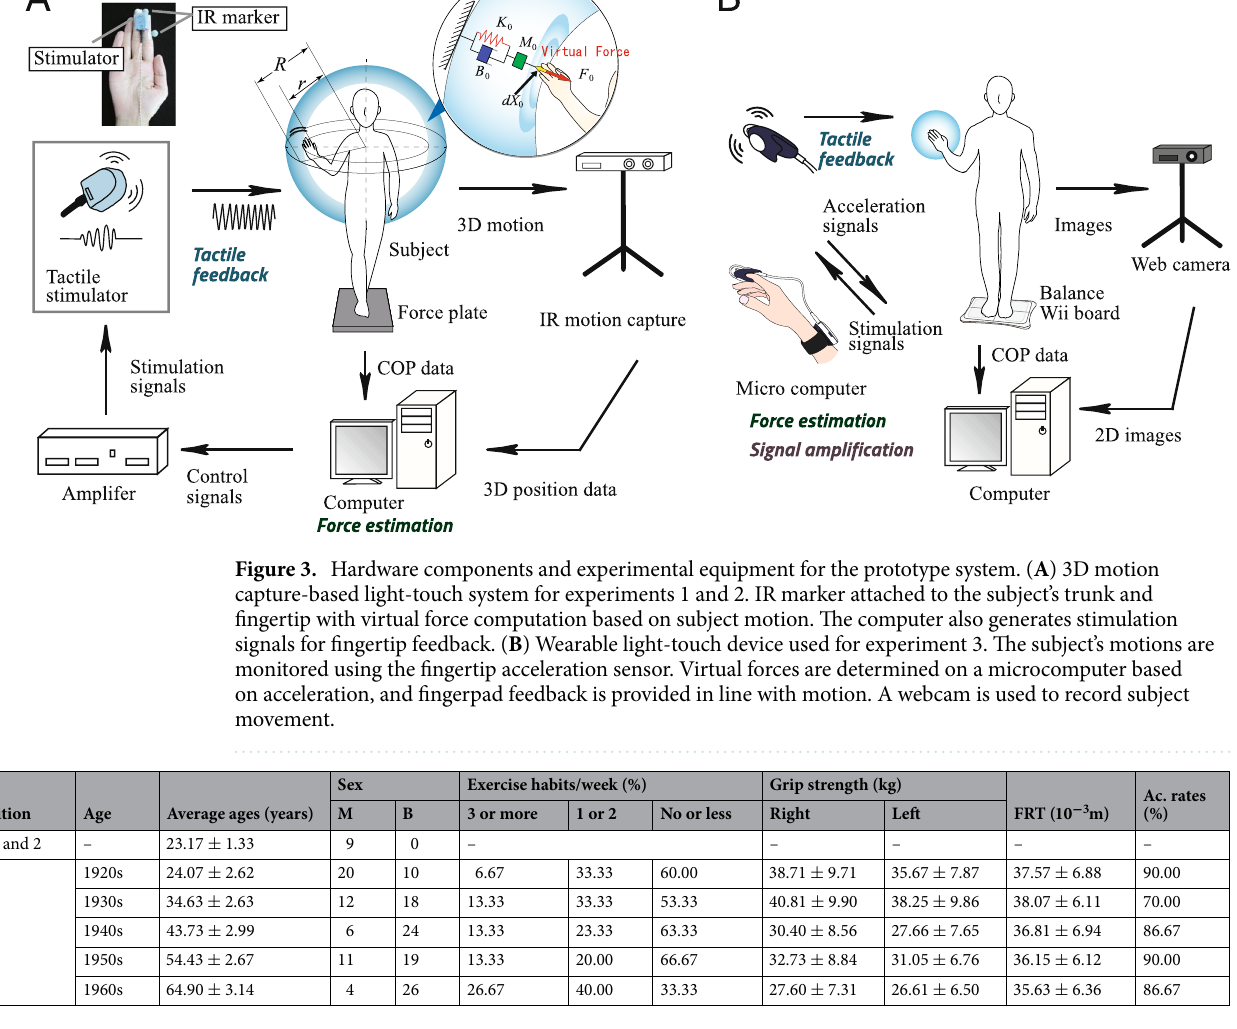
Table 1. Subject information used in experiments. Test scores and exercise habits were not examined for the subjects in experiments 1 and 2. Ac. rates acquisition rates of test score, FRT functional reach test